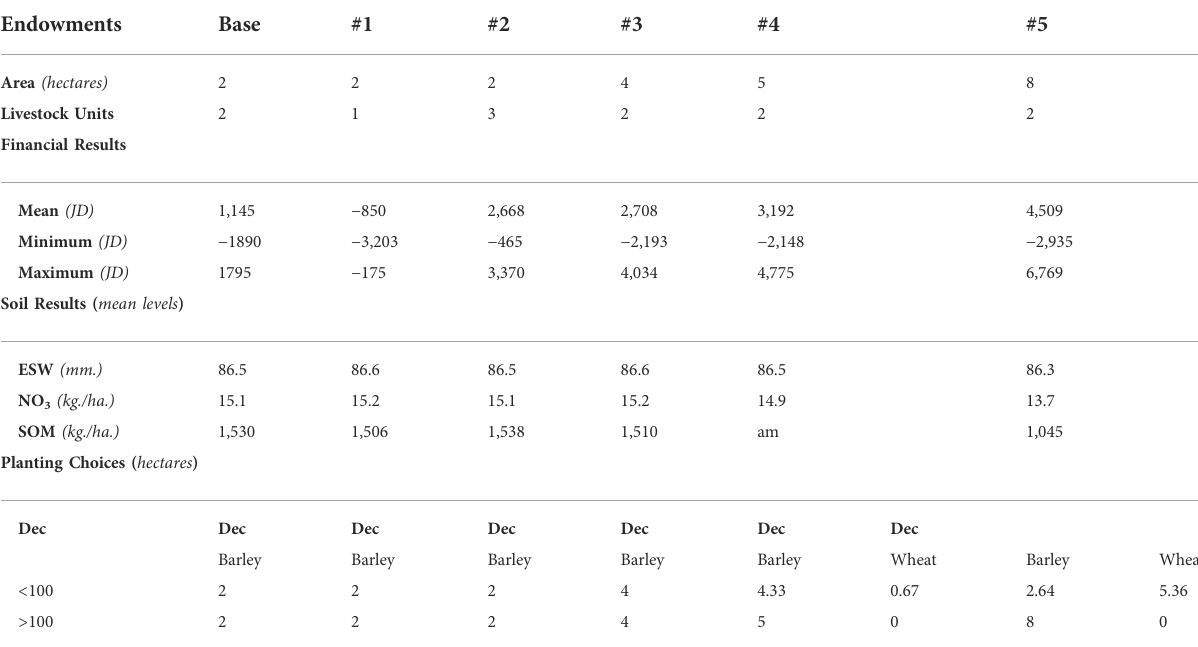
TABLE 2 Model results with zero terminal soil